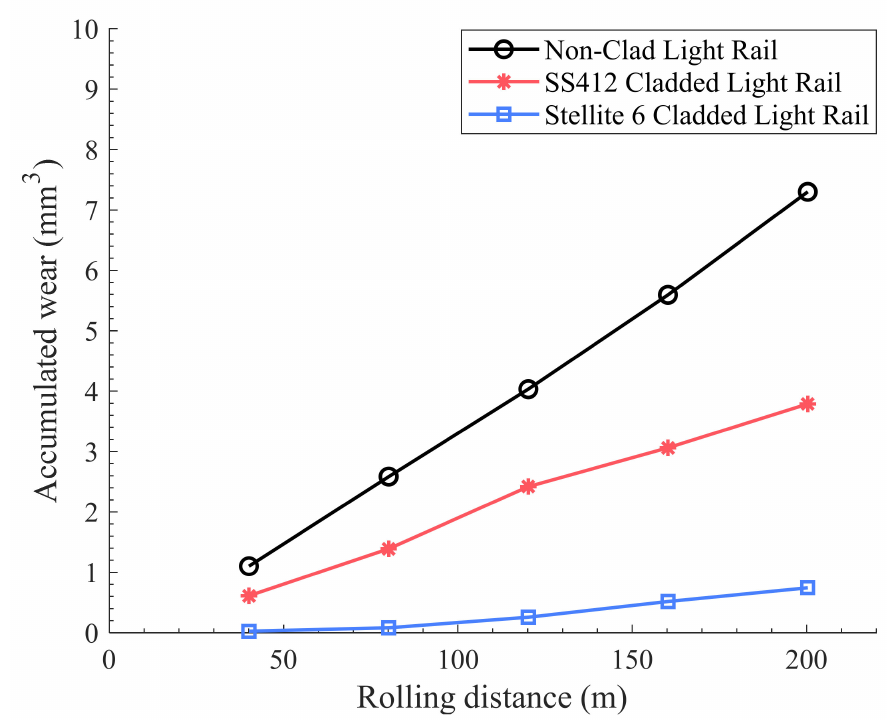
Figure 6. The accumulated wear performance of the non-clad and cladded light rails. The non-clad, low-carbon light rail switch blade exhibits a significantly higher accu- mulated wear compared to the HE400 premium heavy haul rail. This lower wear resistance of the light rail can be attributed to its lower hardness and lower carbon content compared to the non-clad hypereutectoid rail; in addition, the difference in microstructure (i.e., tem- pered martensite vs. pearlite) may be a factor. In general, the wear performance of all cladding alloys decreased with increasing surface hardness; this trend was, however, more marked for the cladding on the light rail switch blade than for those on the hypereutectoid heavy